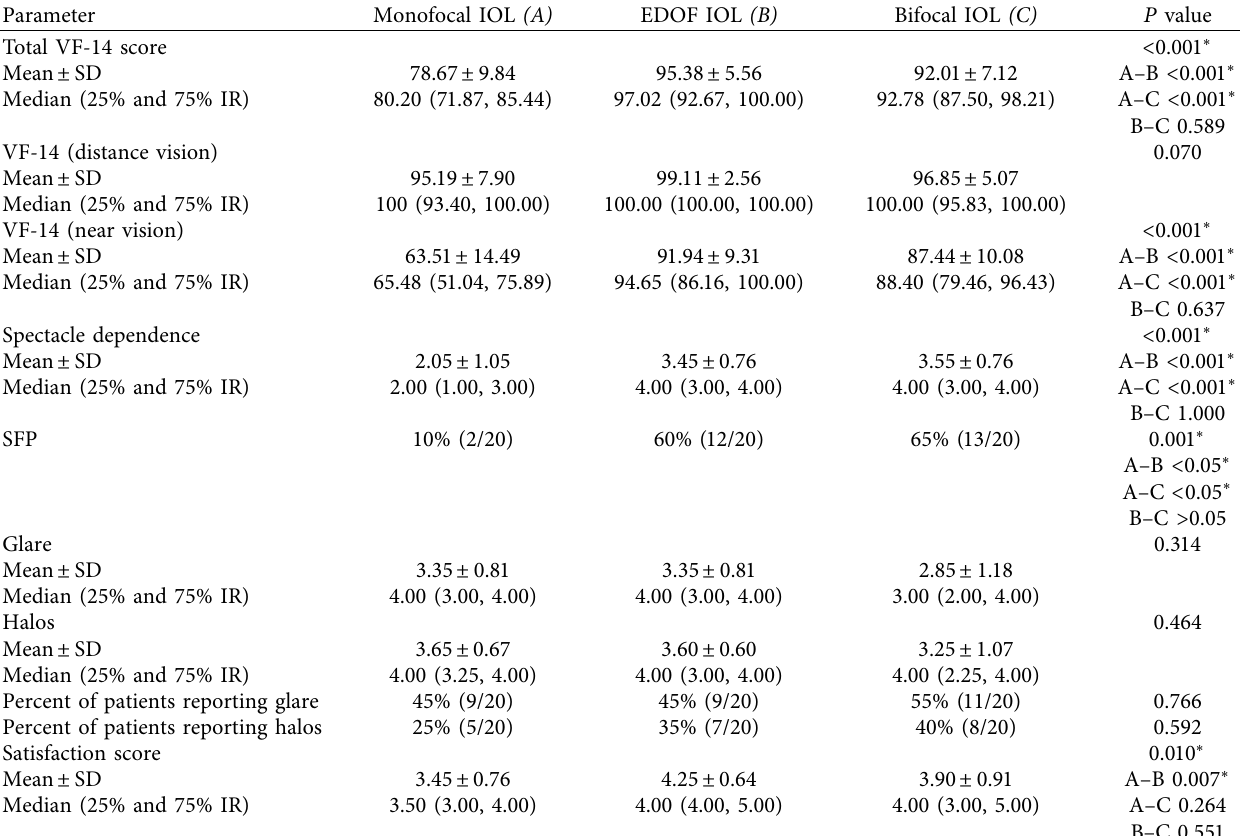
Table 3: Intragroup comparison of visual function questionnaire scores and patients’ overall satisfaction.